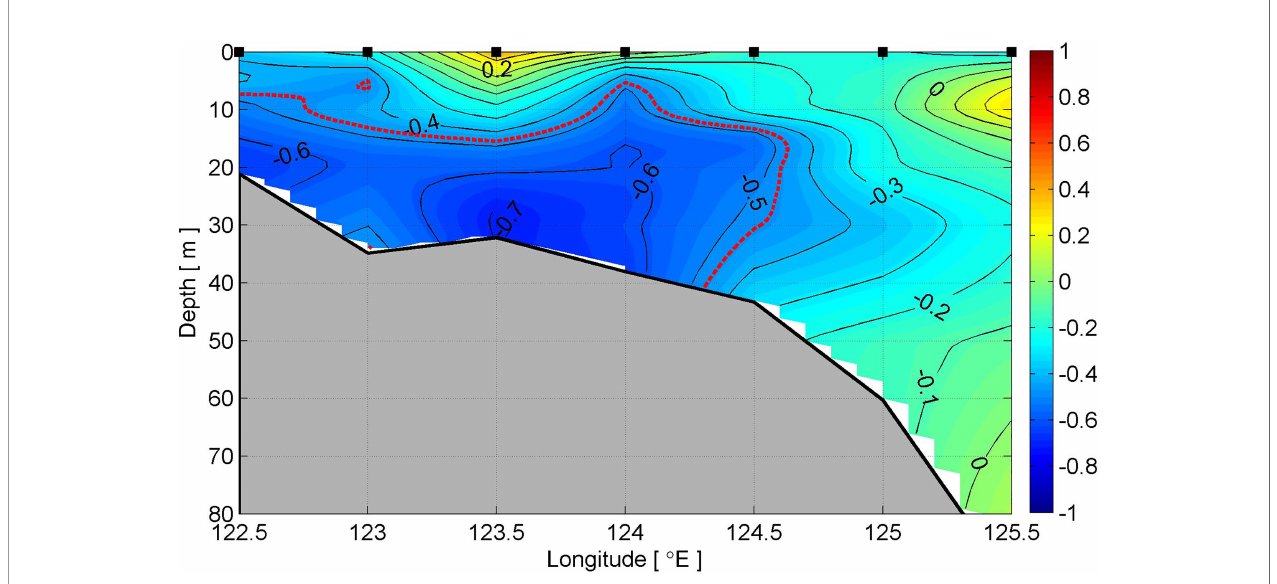
FIGURE 5 | Correlation between DO value along Section C-C in August and ONI in January during 1997 – 2014. Red dashed line indicates the 95% con fi dence